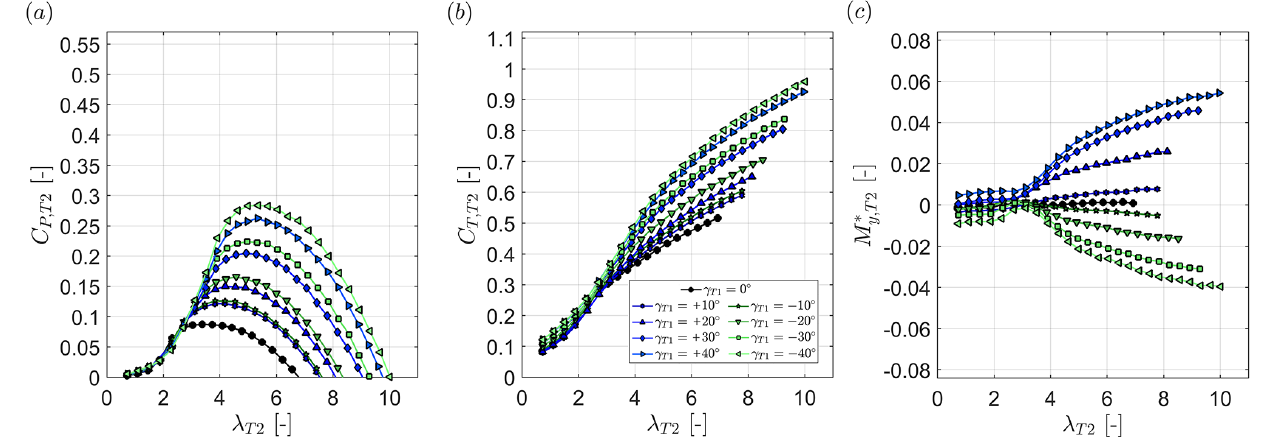
Figure 3. Downstream turbine (a) power coefficient, (b) thrust coefficient and (c) normalized yaw moment as a function of its tip speed ratio λ T2 for different upstream turbine yaw angles γ T1 . The downstream turbine T2 is located at x/D = 3. The turbines are exposed to inflow